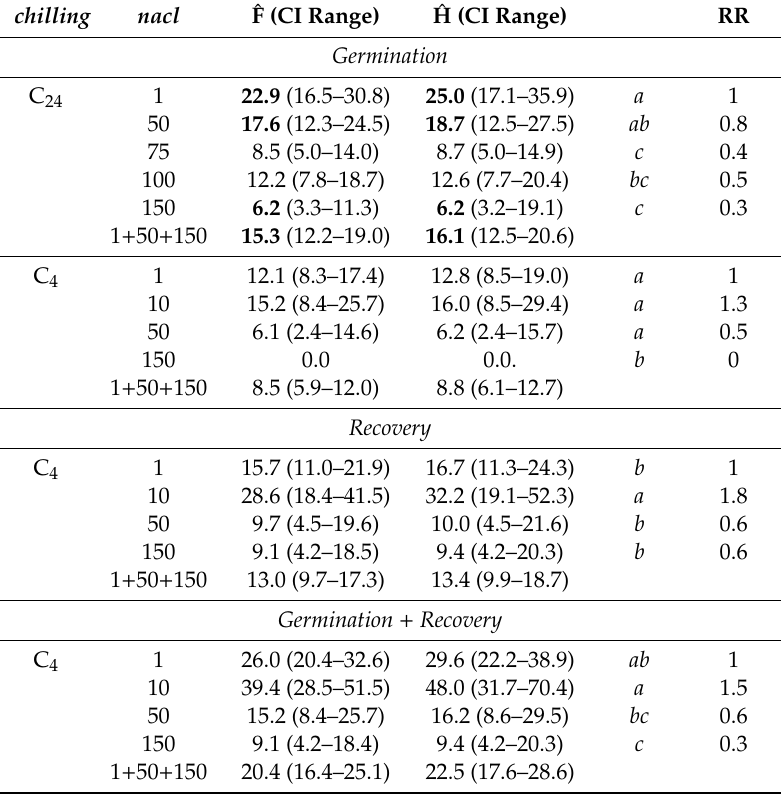
Table 4. Cumulative germination probability (ˆ F ) and cumulative hazard rate ( ˆ H ) in percent along with their 95% CI range (in brackets). Di ff erences between C 24 and C 4 for the same salinity levels ( nacl , in mM) in bold (Wilcoxon p < 0.05); within each trial di ff erent letters for Wilcoxon p < 0.05. RR ( = ˆ F Nx / ˆ F N1 ) = relative risk respect to